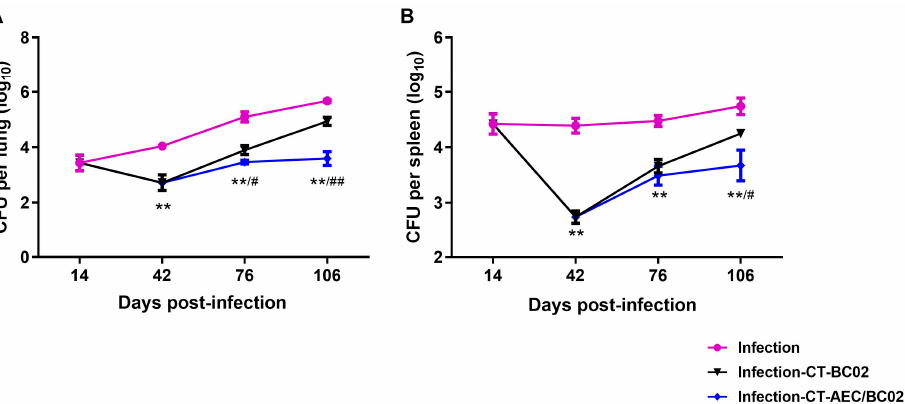
Figure 2. Evaluation of the immunotherapeutic effects of AEC/BC02 vaccine after chemotherapy in the Mtb latent infection mouse model. Bacterial loads in the lungs ( A ) and spleens ( B ) were measured in mice. Data are shown as the mean ± SEM. ** The infection-CT-AEC/BC02 group was compared with the infection group. # / ## The infection-CT-AEC/BC02 group was compared with the infection-CT-BC02 group. Statistical significance was set at # p < 0.05 or **/ ## p < 0.01 ( n = 5).